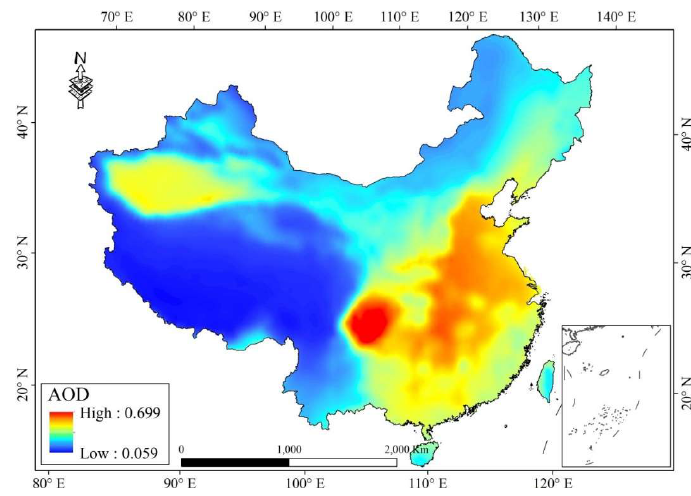
Figure 15. Distribution of the annual mean AOD values over Mainland China during 1980–2015. AOD values in Nagqu plateau and the Ali mountains were 0.0120 ~ 0.082 and 0.044 ~ 0.106, 486 respectively. 487